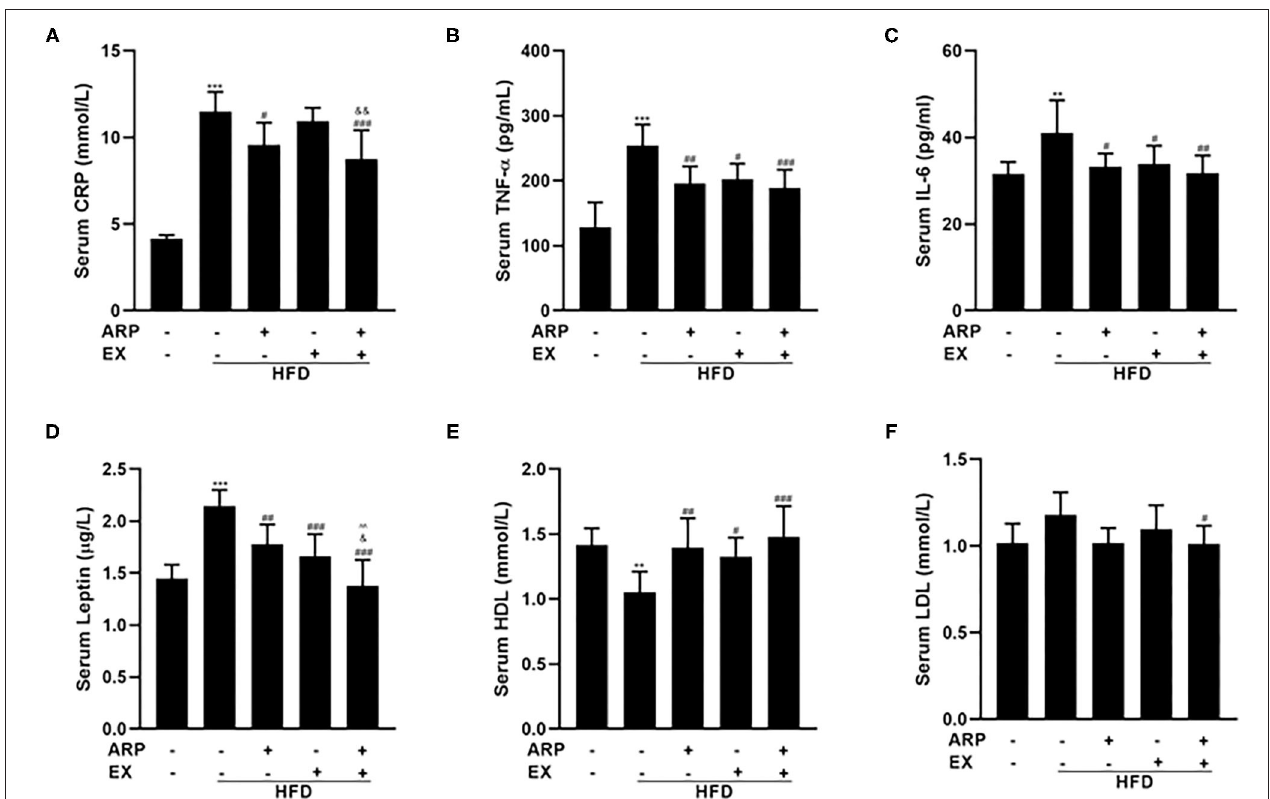
FIGURE 3 | Effects of ARP and EX on serum cytokines in HFD-fed mice. Serum contents of CRP (A) , TNF- α (B) , IL-6 (C) , leptin (D) , HDL (E) , and LDL (F) in HFD-fed mice treated with ARP and EX. All the values are exhibited as the mean ± SME, n = 8. ** p < 0.01 and *** p < 0.001 vs. related control group. # p <